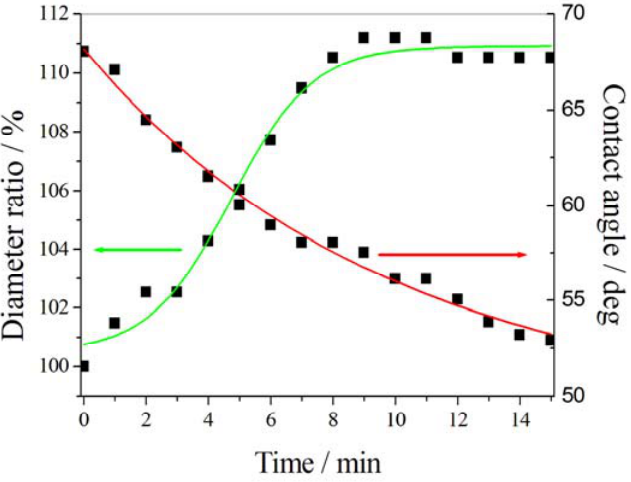
Figure 36. UV induced changes in the hydrophobicity on poly(NSP-co-MMA) coated glass